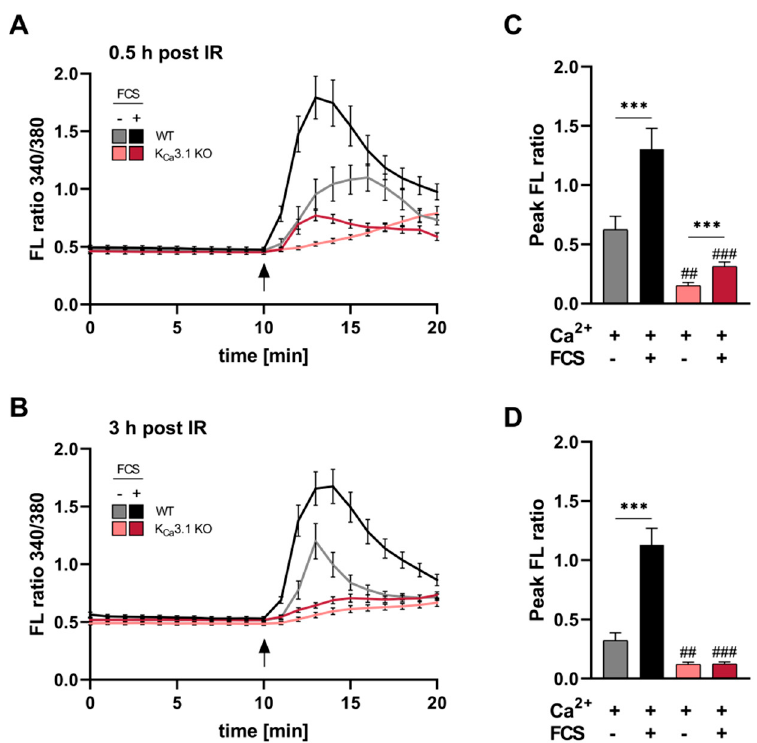
Figure 2. IR-induced [Ca 2 + ] i signals in MMTV-PyMT breast tumor cells depend on K Ca 3.1 channels ( A,B ) Acute Ca 2 + signals of MMTV-PyMT mammary tumor cells evoked by Ca 2 + (1.8 mM) superfusion only (gray and light red lines) or Ca 2 + (1.8 mM) plus 5% fetal calf serum (FCS; black and red lines) after 30 or 180 min of irradiation (2 Gy). Irradiated FURA-2-AM-loaded cells were monitored in Ca 2 + -free bu ff er for 10 min prior to the respective treatments as indicated. Arrow indicated bu ff er replacement. ( C,D ) The mean peak fluorescence (FL) ratio of the 340 / 380 nm wavelength was determined relatively to the respective baseline FL ratio for MMTV-PyMT K Ca 3.1 KO ( n = 14–28 cells per condition derived from three di ff erent breast tumors) and WT ( n = 21–27 cells per condition derived from three di ff erent breast tumors) groups. Statistical analysis was performed by two-way analysis of variance (ANOVA) with * p < 0.05, ** p < 0.01, *** p < 0.001 indicating statistical di ff erences between FCS-treated and -untreated groups and ## p < 0.01, ### p < 0.001 for di ff erences between genotypes either at Ca 2 + plus FCS or Ca 2 + “only” condition.